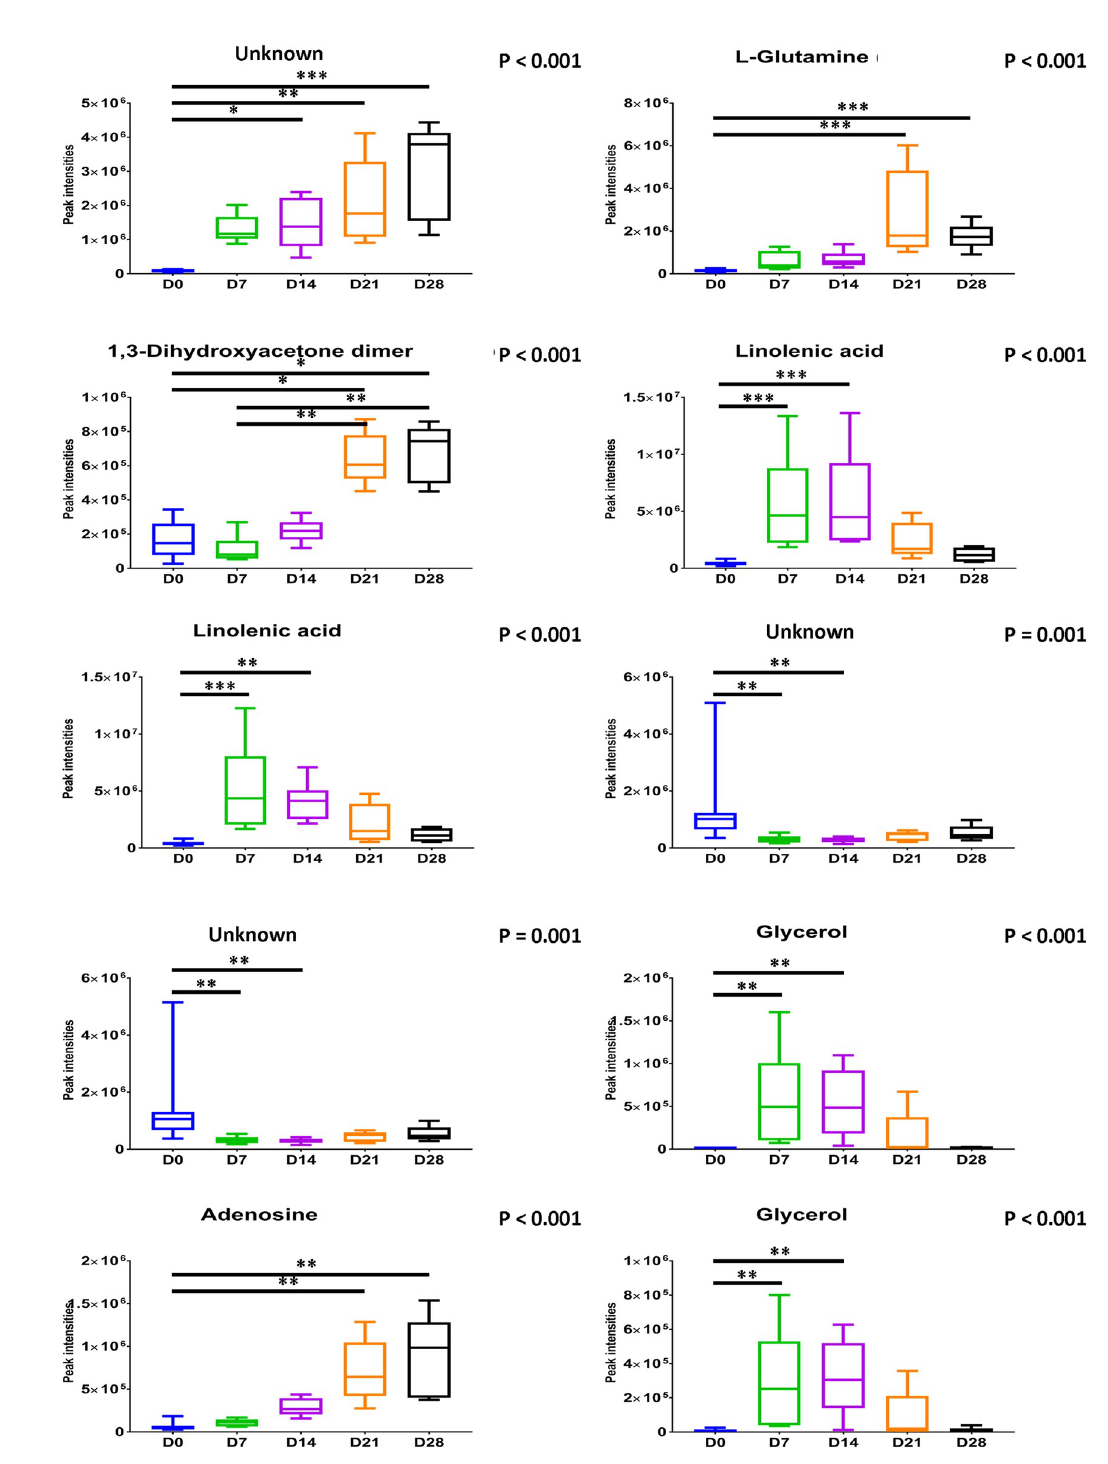
Fig 2. Boxplots showing significantly varied metabolites as identified from multivariate analysis across time points. Kruskal–Wallis test with accompanying Dunn-Bonferroni post hoc analyses were performed ( n = 6). � P < 0.05, �� P < 0.01, ��� P < 0.001.